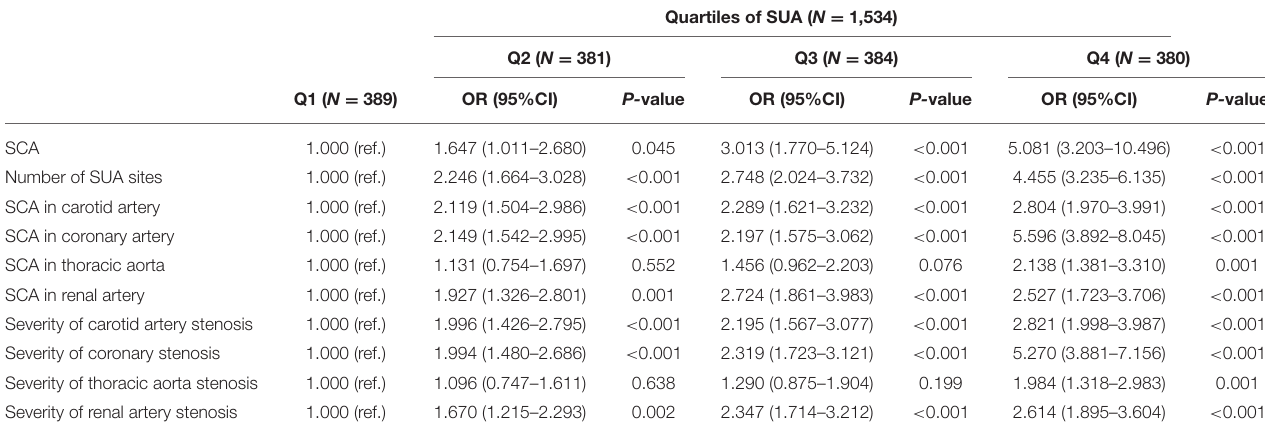
TABLE 3 | Risk of SCA according to baseline serum uric acid quartiles in adjusted models.